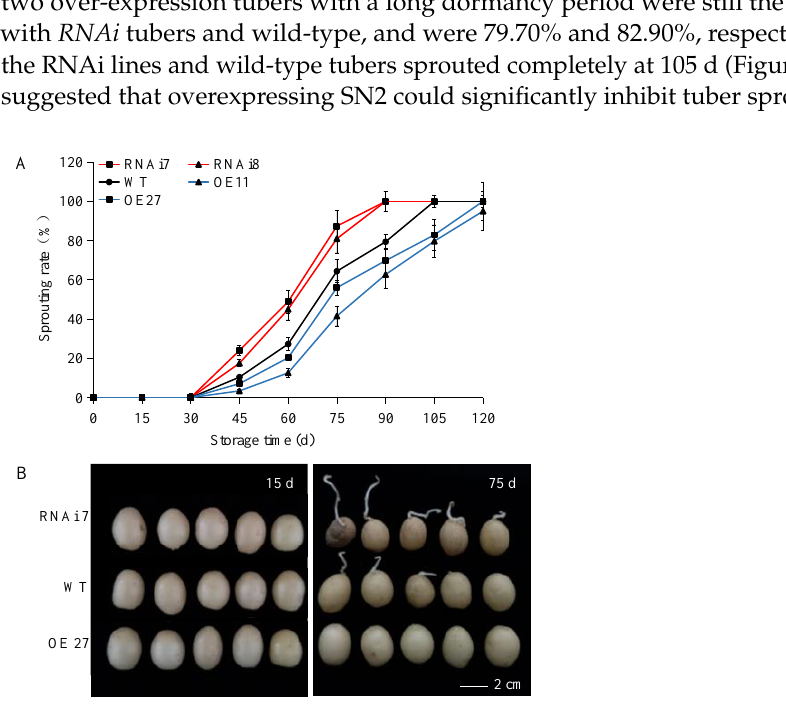
Figure 1. Sprouting rate and phenotypes of StSN2 transgenic tubers and controls during different storage times. ( A ) Statistical results of sprouting rate. ( B ) Sprout phenotypes on the 15th and 75th day of storage. Data are means ± SD of three biological replicates. Scale bar = 1 cm.